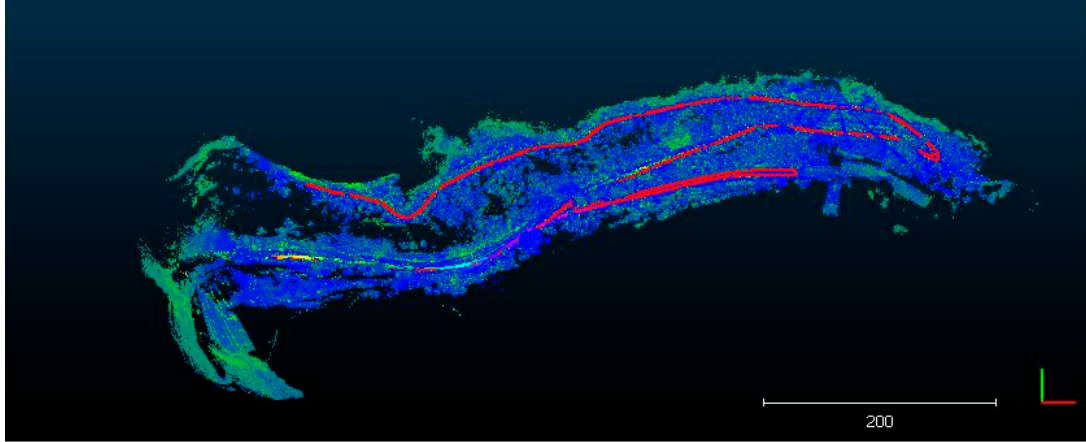
Figure 8. Cortes de Pallás MMS (Mobile Mapping System) point cloud: 3D point cloud (intensity scale) and the closed-loop trajectory (red line) carried out with the MMS. Table 5. Advanced parameters applied to cloth simulation filter (CSF) operation to perform the segmentation between ground and non-ground points.